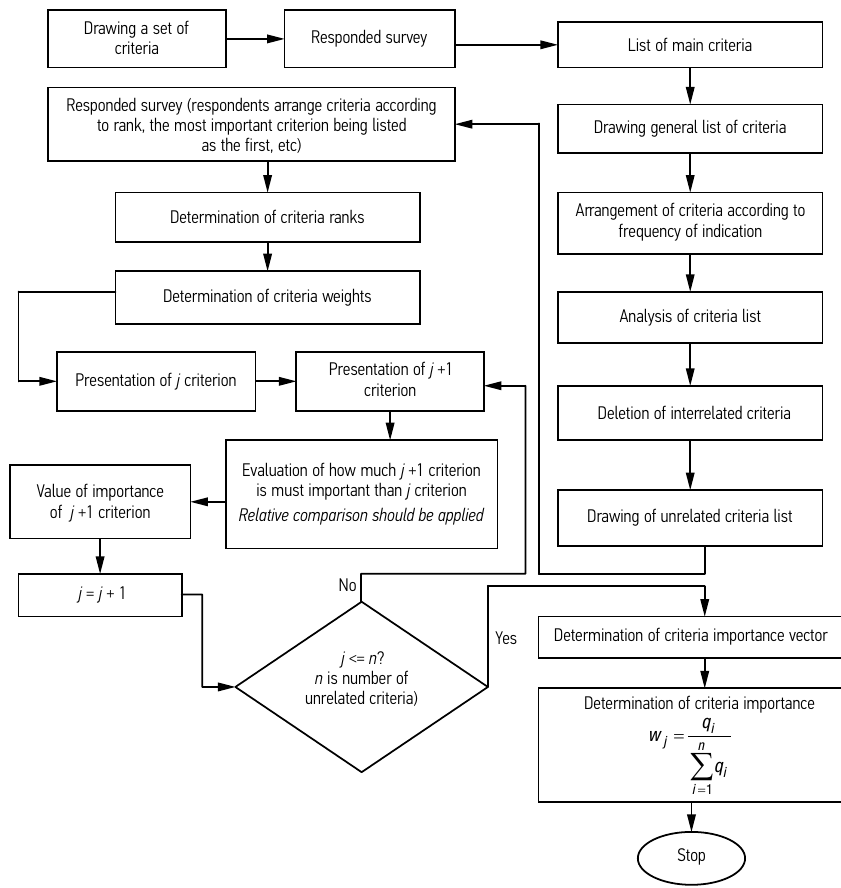
Fig 6. Determining the criteria weights based on (Keršulienė, Turskis 2011)